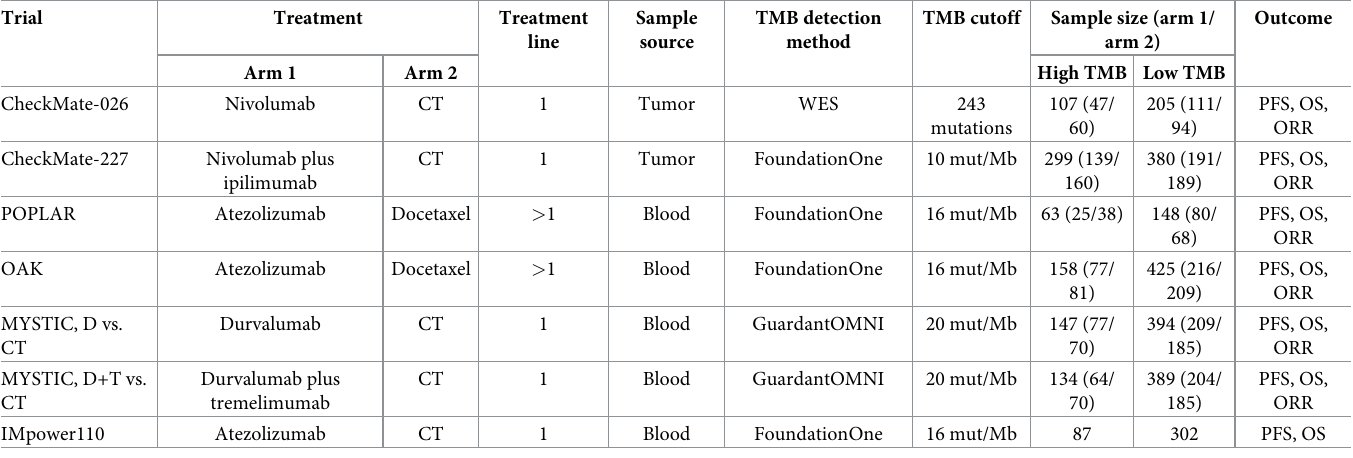
According to Cochrane Collaboration’s tool for assessing risk of bias, all trials had a low risk of bias in most domains (S2 Table). High TMB versus low TMB in patients treated with immunotherapy The predictive value of TMB in patients receiving immunotherapy was investigated by pooling together the survival and response outcomes of all eligible studies (S3 Table). Meta-analysis of 27 datasets comprising 2812 patients demonstrated that patients with high TMB had favorable PFS (HR = 0.54, 95%CI: 0.46–0.63, P < 0.001, I 2 = 58.5%, Fig 2) compared with those with low TMB. Stratified analyses according to baseline features showed that high TMB predicted pro- longed PFS in all subgroups except for PD-L1 inhibitors (Table 3). High TMB was associated with longer PFS in patients treated with only PD-L1 inhibitors (HR = 0.76, 95%CI: 0.57–1.02, Table 2. Baseline characteristics of studies in meta-analysis comparing immunotherapy with chemotherapy in NSCLC patients with high or low